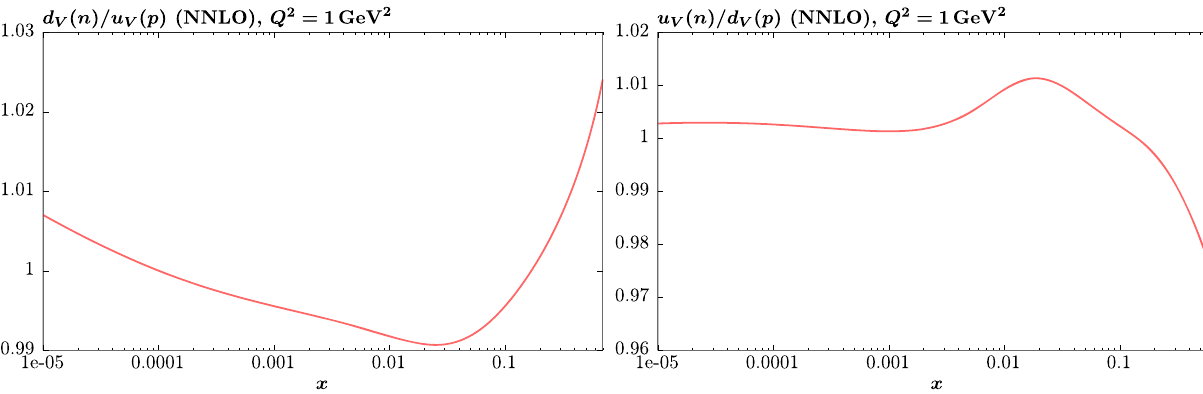
Fig. 9 Ratio of neutron down (up) valence to the proton isospin partner, at Q 2 = 1 GeV 2 , shown in the left (right)